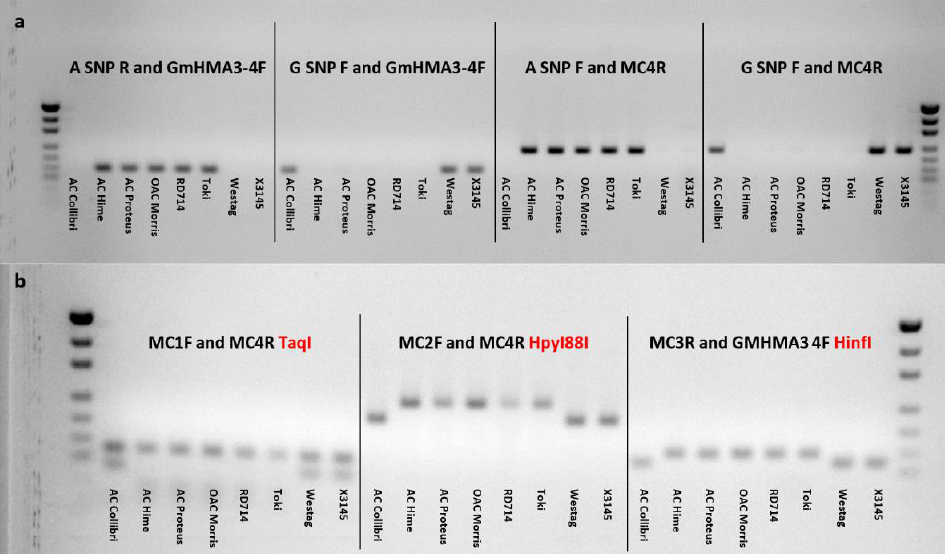
Figure 6. The PCR products of the amplified Cda1 gene among the eight lines. ( a ) High accumulating Cd lines indicated by the bands present among the primer pairs (A SNP R and GmHMA3-4F) and (A SNP F and MC4R), and the low accumulating Cd lines visible by bands present at (G SNP F and GmHMA3-4F) and (G SNP F and MC4R). The amplified digested products for the dCAPS marker pairs; ( b ) low Cd-accumulating lines digested with TaqI resulted in two bands. Lines digested with HpyI88I and HinfI resulted in low Cd accumulators having lower bands compared to the high Cd accumulators. Controls are not shown, using the pUC19 DNA/MspI (HpaII) ladder.